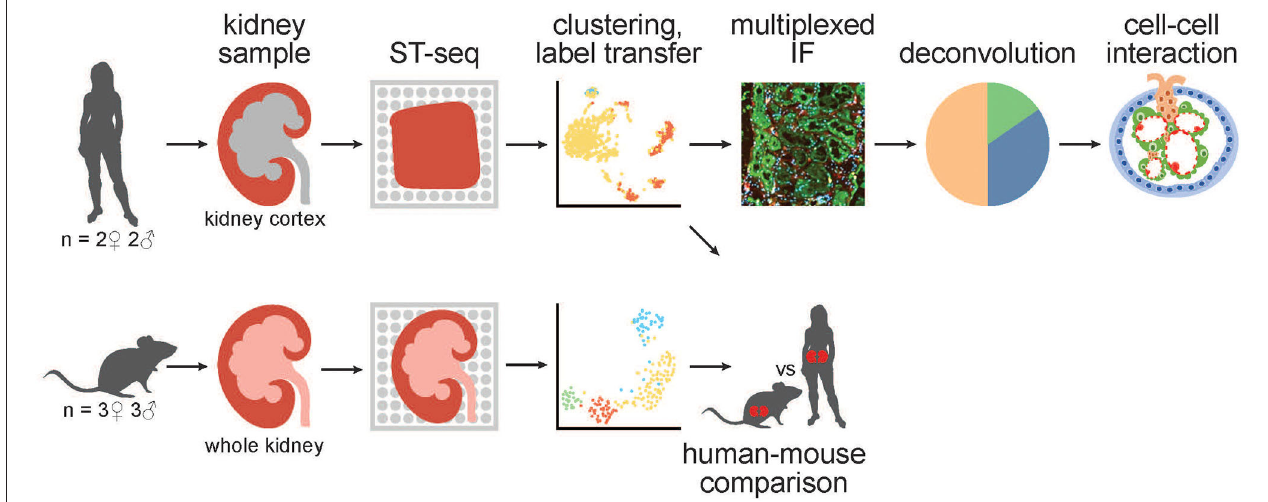
FIGURE 1 | A schematic of the workflow for generation and analysis of mammalian kidney ST-seq datasets. (From left to right) We performed ST-seq on four human kidney cortical tissues (2 women, 51–53 years old and 2 men, 54 and 56 years old) and six mice whole kidneys (3 males, 8 weeks old and 3 females, 6 weeks old). With the generated ST-seq datasets, we performed clustering and label transfer to define the location of specific nephron segments or regions in human and mouse kidneys, respectively. We selected the cortical kidney regions in the mouse ST-seq datasets and performed functional analysis on genes that were differentially expressed between species in the cortex. In the human cortical kidney tissues, we performed multiplexed IF on consecutive deeper sections to correlate the label transfer annotation of the functional nephron segments with histomorphology. Last, we investigated the CCI by screening for L–R gene pair co-expression in glomerular and PT–PC ST-spots identified by